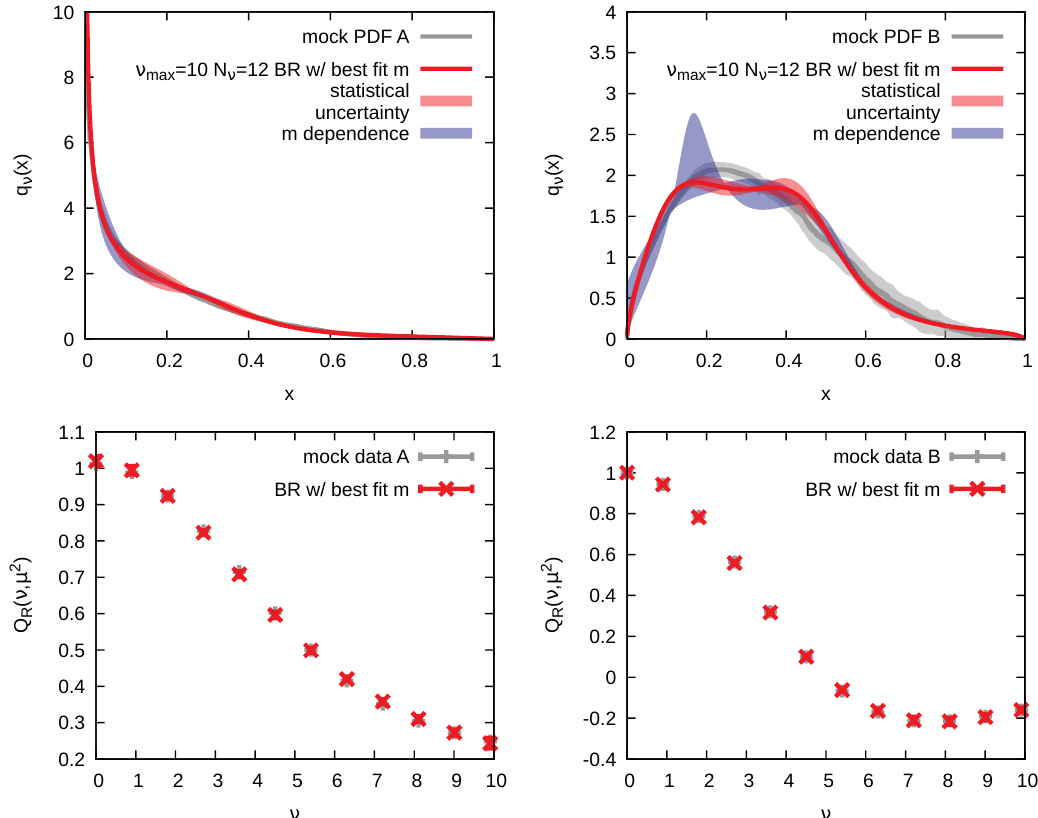
Figure 15 . x -space PDF’s reconstructed using the Bayesian reconstruction (BR) method from N (cid:23) = 12 Io(cid:11)e-time data points on the interval (cid:23) = [0 ; 10] (top) as well as the input data (gray crosses) compared to the data arising from the reconstructed PDF (red crosses) in the bottom